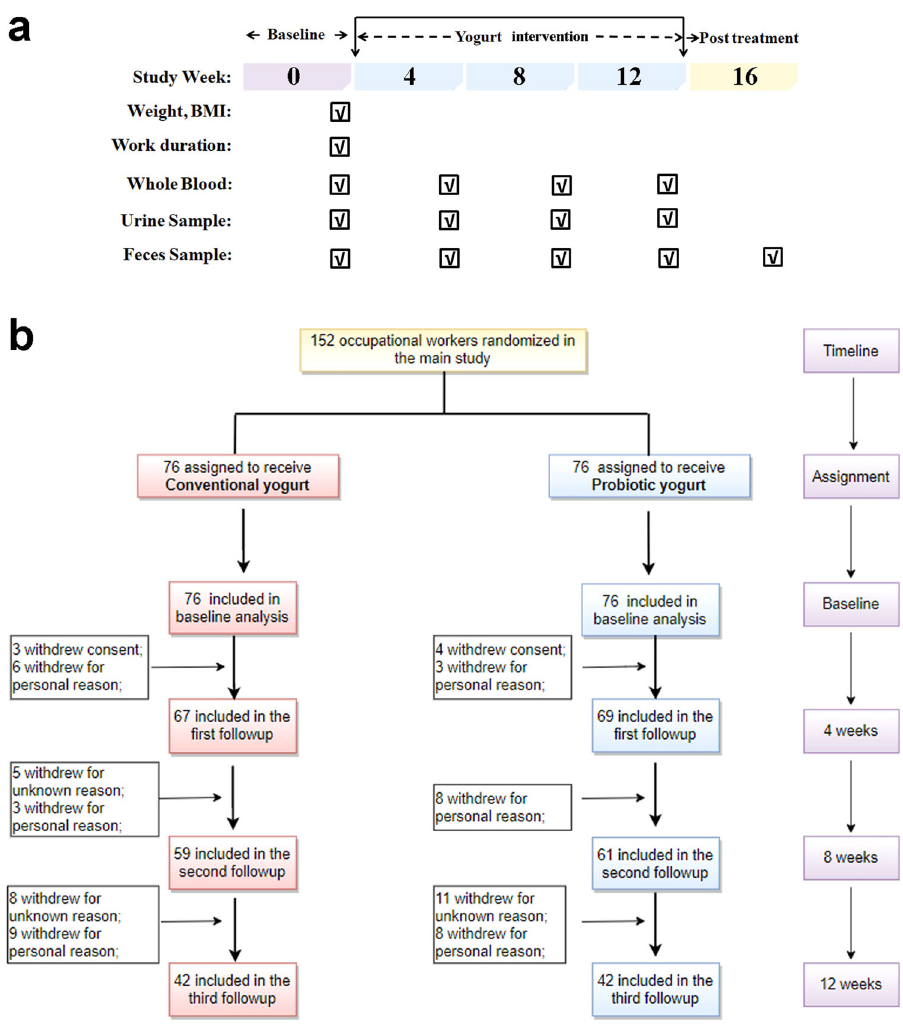
Fig. 1 Flow diagram of the cohort of this trial. a Trial design. b Flow diagram of participant